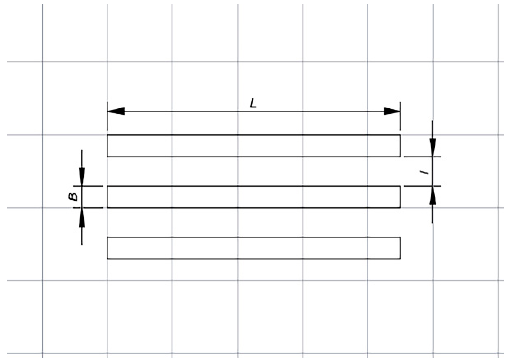
Figure 12. Schematic diagram of groove texture.